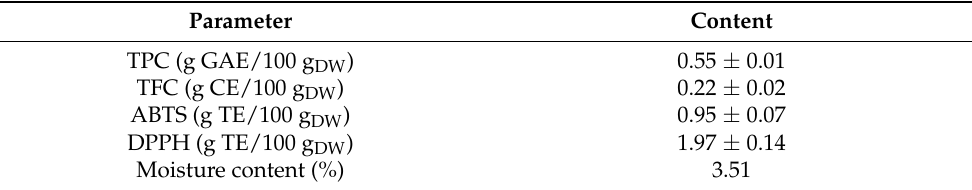
Table 1. Characterization of the red banana